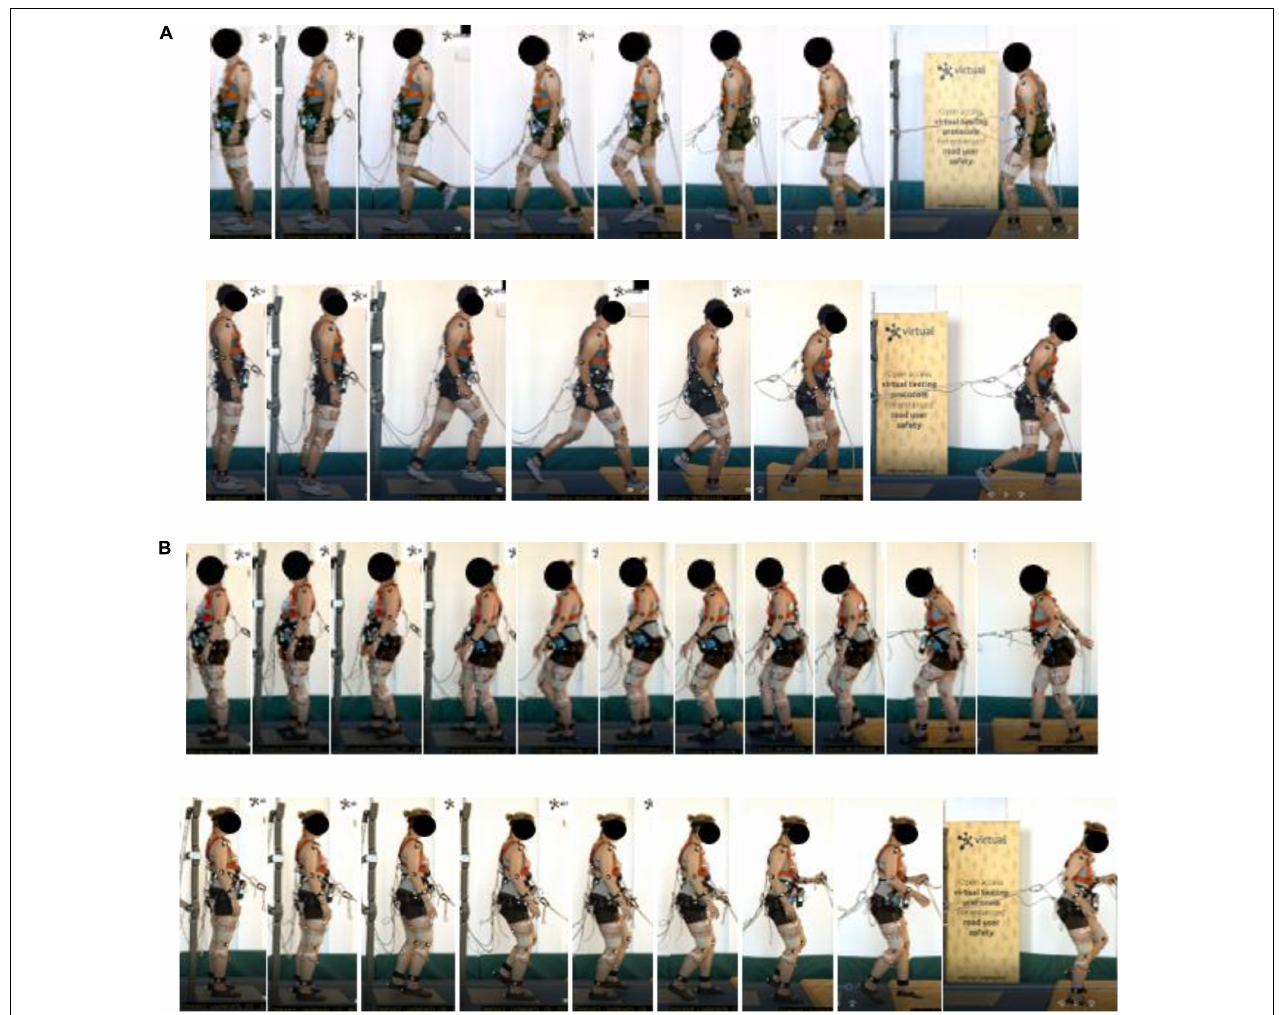
FIGURE 4 | Typical forward and rearward step strategy, (A) male (Volunteer 22) and (B) female (Volunteer 10).